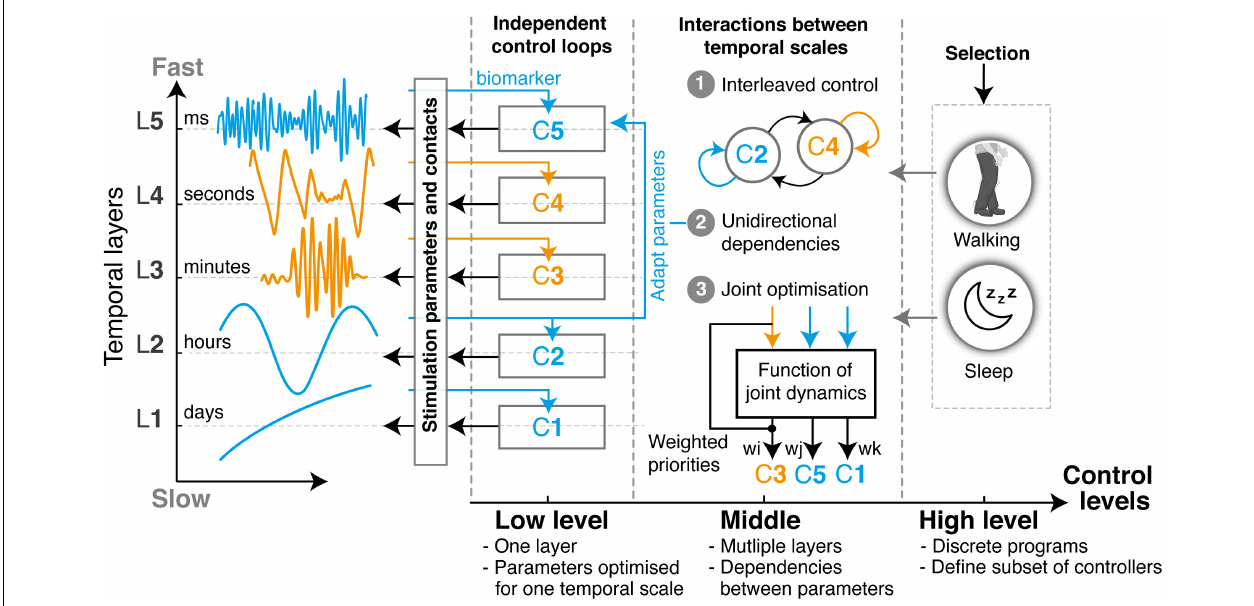
FIGURE 2 | Layered multi-objective control for closed-loop DBS. Multi-objective control approaches for closed-loop DBS may mirror the layered structure of clinical and neural manifestations to optimize the control of multiple symptoms occurring concurrently or intermittently. Such a structure enables to distribute complexity over three incremental levels: The low level is composed of parallel independent control loops, each one operating at a unique temporal layer. The design and tuning of each controller (indicated as C1–C5) can thus be optimized for the specificities of a single manifestation, independently from changes that may arise from dependencies with other layers. Examples of closed-loop DBS in the literature, such as beta burst-based control of pathological beta synchrony, or gamma-driven control of dyskinesias, have been predominantly restricted to this layer. Second, cross-layer dependencies and interactions can be implemented in the middle level to address multiple symptoms. These may use (1) state machine controllers for switching between low-level controllers, (2) unilateral dependencies that tune the parameters of one layer using feedback from another, or (3) optimization controllers able to jointly tune various low-level control parameters based on a weighted evaluation of various manifestations, side effects and interferences. Finally, the high-level control layer enables the automatic selection of programs, which fit the discrete states occurring in layer L0. Each program will activate (or de-activate) a subset of low- and middle-level controllers, while specifying sensing channels and stimulation parameters. For instance, the way controllers might need to respond during sleep may not be the same as during the day. Overall, with this organization, multi-objective control therapies can easily be built, tuned, and combined in a modular way for each individual patient. All existing algorithmic approaches for closed-loop control proposed over the past years would easily be integrated under such